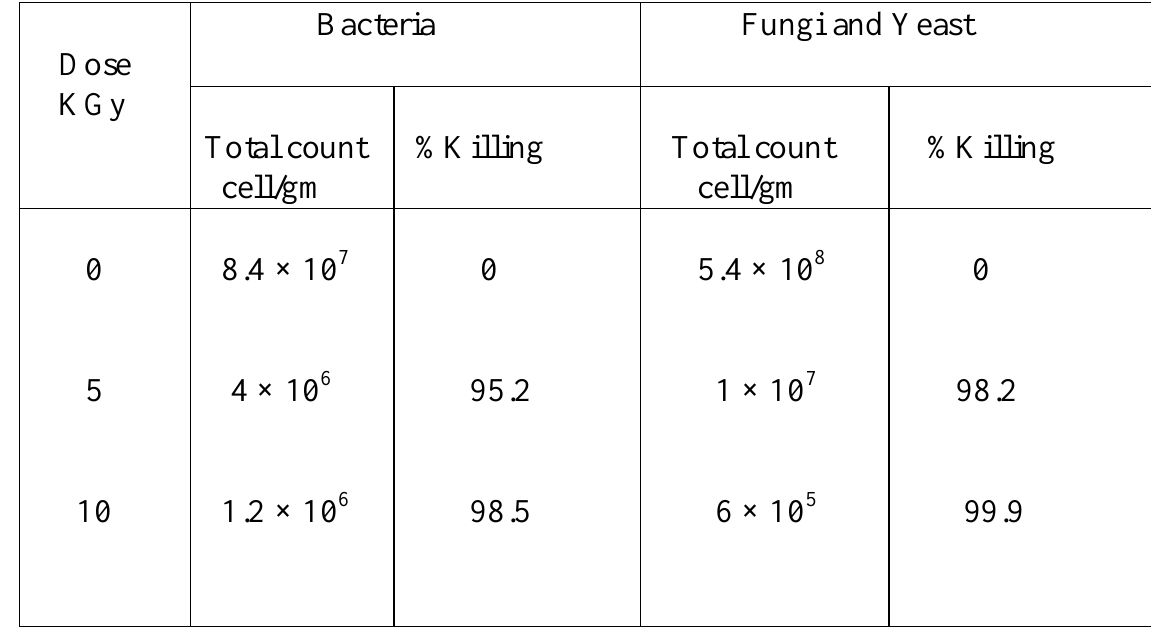
Table (3): Effects of 5KGy and 10KGy gamma radiation on total microbial counts